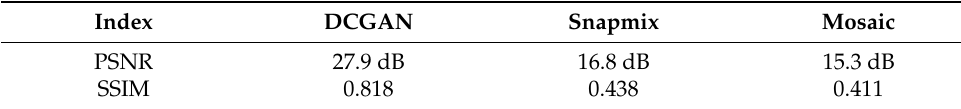
Table 2. Comparison of quantitative results of different